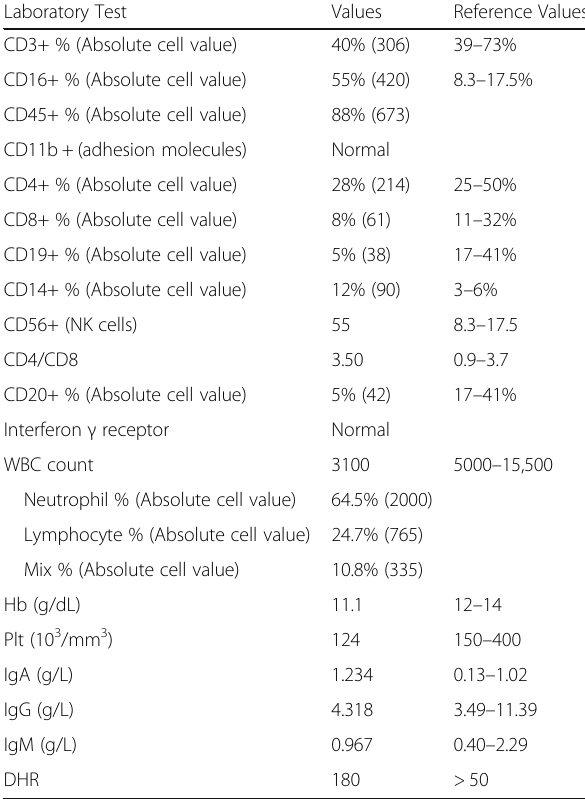
Table 1 The results of flow-cytometry and blood count Laboratory